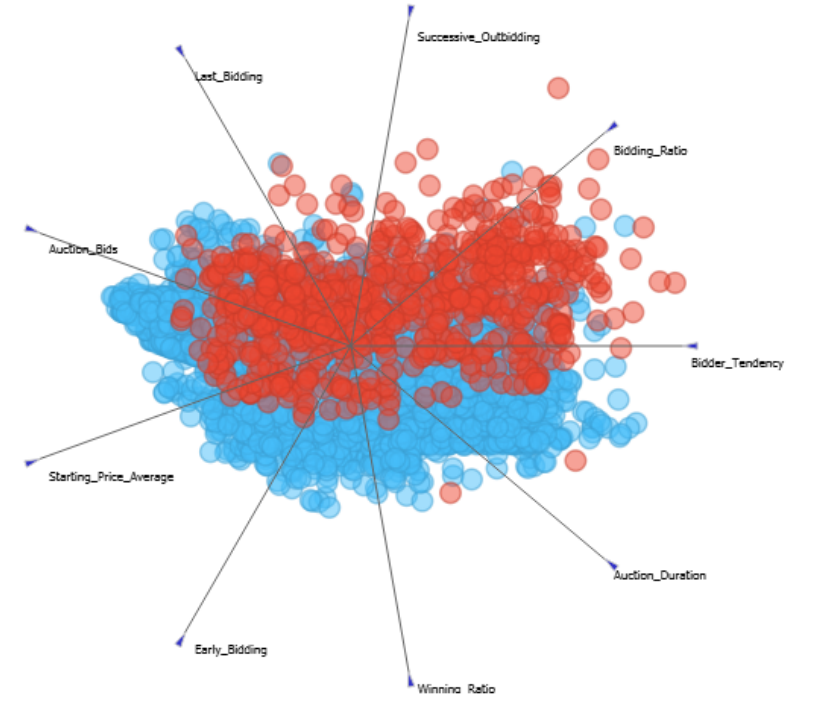
Figure 6. FreeViz projection—Auction Fraud data set.